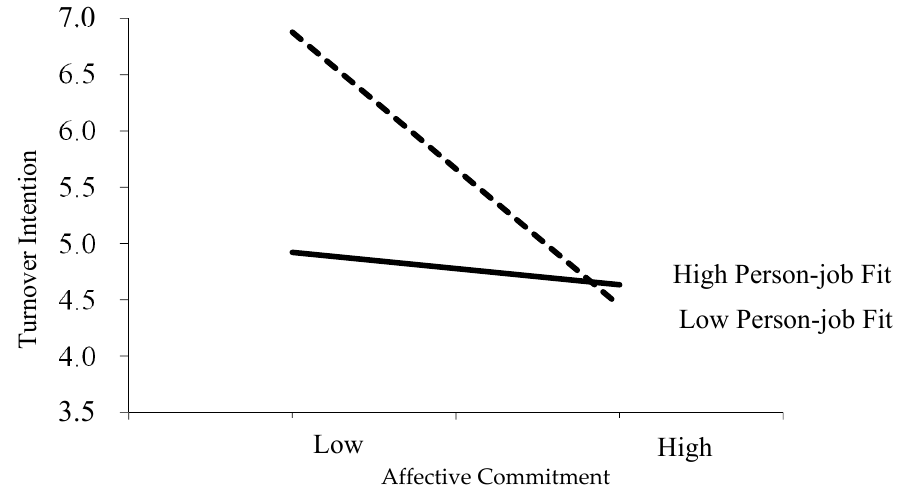
Figure 2. Influence of entrepreneurial leadership on affective commitment under different person-job fit scenarios.